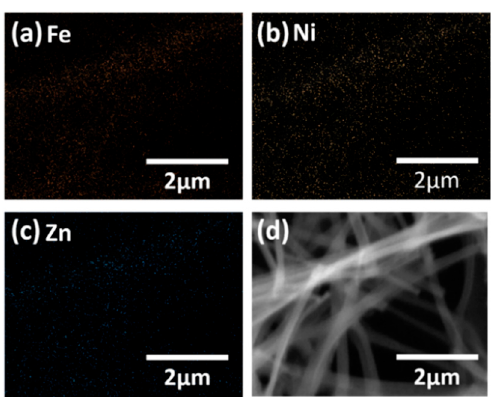
Figure 4. Energy dispersive X-ray spectroscopy ( EDX) elemental mapping of Ni 0.5 Zn 0.5 Fe 2 O 4 nanofibers: ( a ) Fe, ( b ) Ni, ( c ) Zn, and ( d ) FE-SEM image. Table 3. Energy dispersive X-ray spectroscopy (EDX) spectrum analysis results of Ni 0.5 Zn 0.5 Fe 2 O 4 nanofibers.